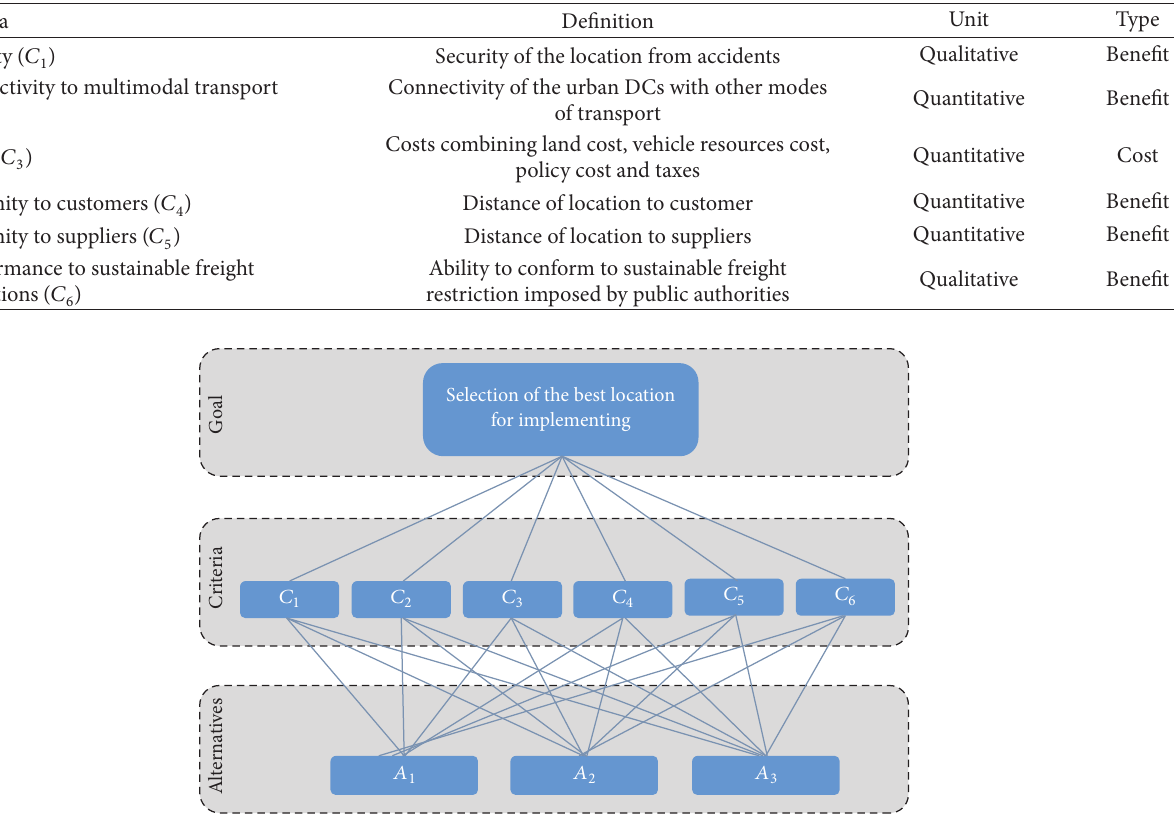
Figure 1: The hierarchical structure of the selection of DCs’ location.